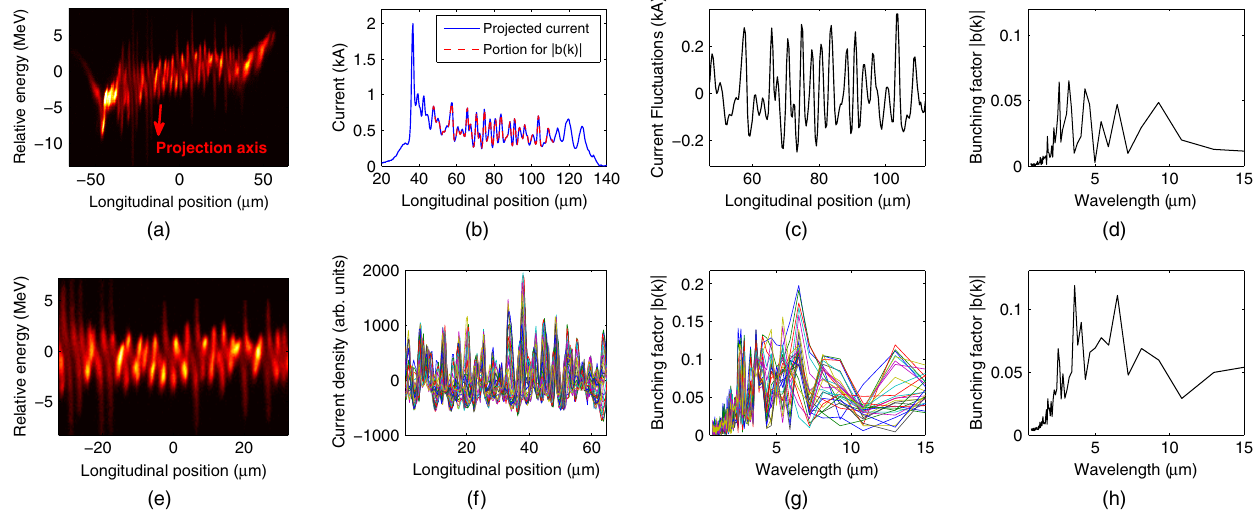
FIG. 11. Example of microbunching measurement for an image with 0.5 kA peak current, laser heater off, and 44 MV XTCAV voltage for both the normal (a – d) and modified (e – h) metrics. (a) Electron phase space imaged with the XTCAV. (b) Projected electron density at 0.1 rad, with only the center of the beam used for bunching factor calculations. (c) We remove the bunch curvature by fitting a second order polynomial to the central portion of the bunch current. (d) We calculate the bunching factor from the current fluctuations for a single shot. (e) For the modified method, we start by removing the energy and current curvature in the beam by fitting a fourth order polynomial. (f) We produce current fluctuations for each individual lineout of energy phase space and (g) calculate the bunching factor for each lineout. (h) Finally we average j c ð k Þj 2 to find the final bunching factor of a single